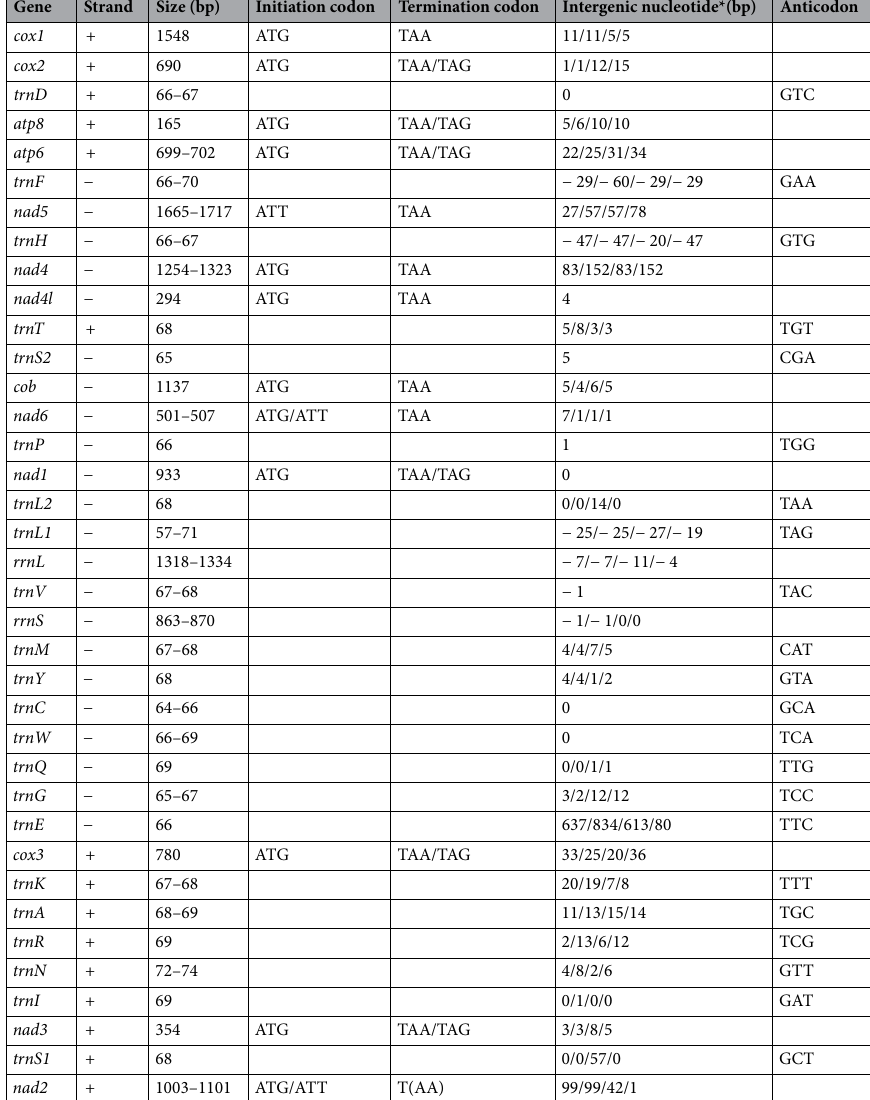
Table 2. Summary of the gene features of Clithon oualaniense , Clithon sowerbianum , Nerita chamaeleon and Nerita japonica . Intergenic Nucleotide*(bp): positive values indicated the interval sequence of adjacent genes, and negative values indicated the overlapping of adjacent